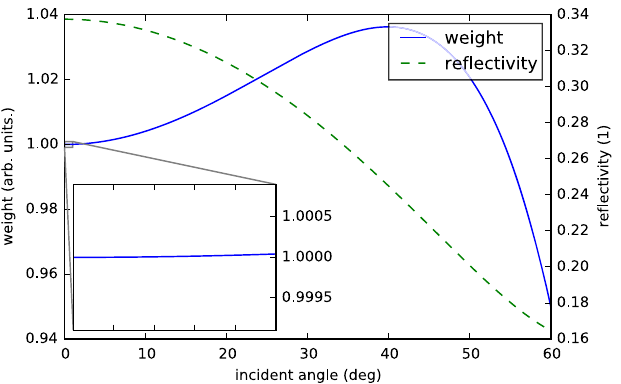
FIG. 11. The Fourier transform of the surface employed in the simulation. Note that in order to make high-order components visible, we set the threshold amplitude to be 1 μ m 3 , which means that the components with amplitudes larger than 1 μ m 3 would be plotted as if their amplitudes are 1 μ m 3